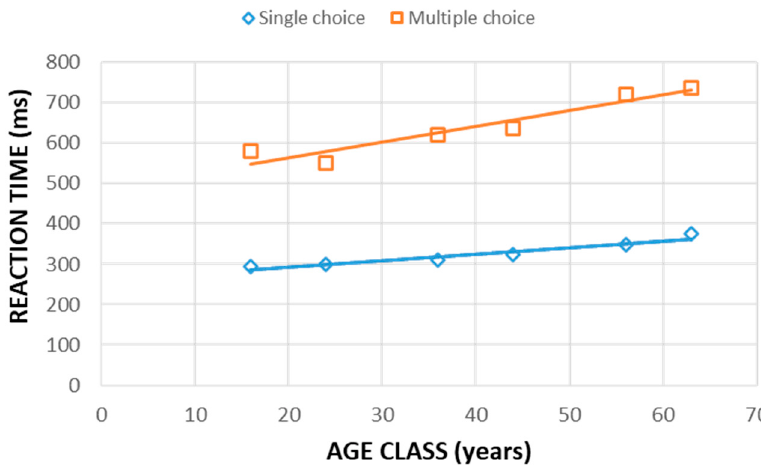
Figure 2. Mean reaction time values of the overall population vs. age for single and multiple-choice cognitive tests. Source: Authors’ elaboration of data from [54].